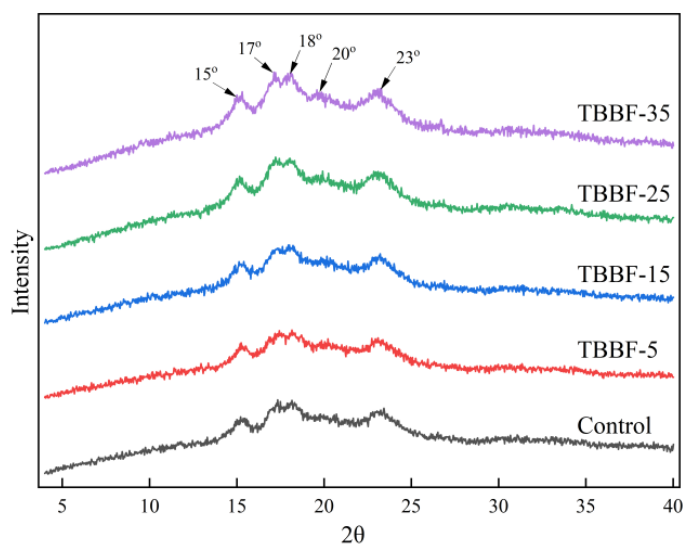
Figure 2. XRD patterns of Tartary buckwheat dried noodles with different substitutions of Tartary buckwheat bran flour. Control, TBBF-5, TBBF-15, TBBF-25, and TBBF-35 represent Tartary buckwheat dried noodles with 0%, 5%, 15%, 25%, and 35% substitution of Tartary buckwheat bran flour, respectively.